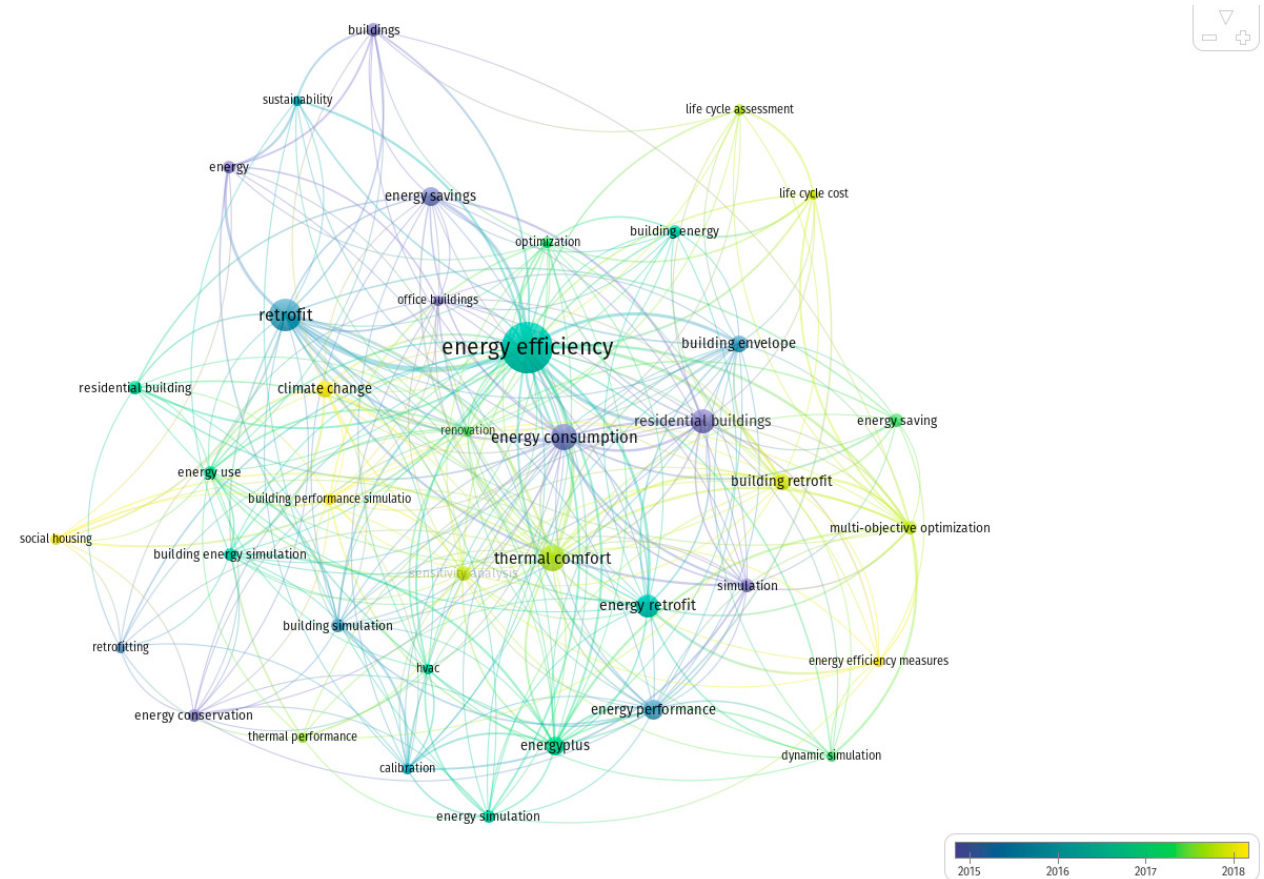
Figure 7. Articles related to building envelope energy retrofit based on the publication year.